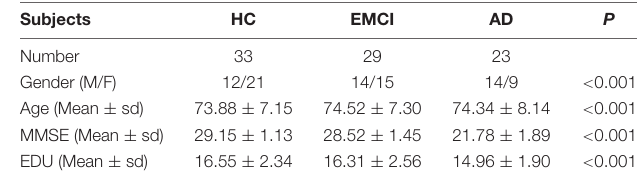
TABLE 1 | Participant